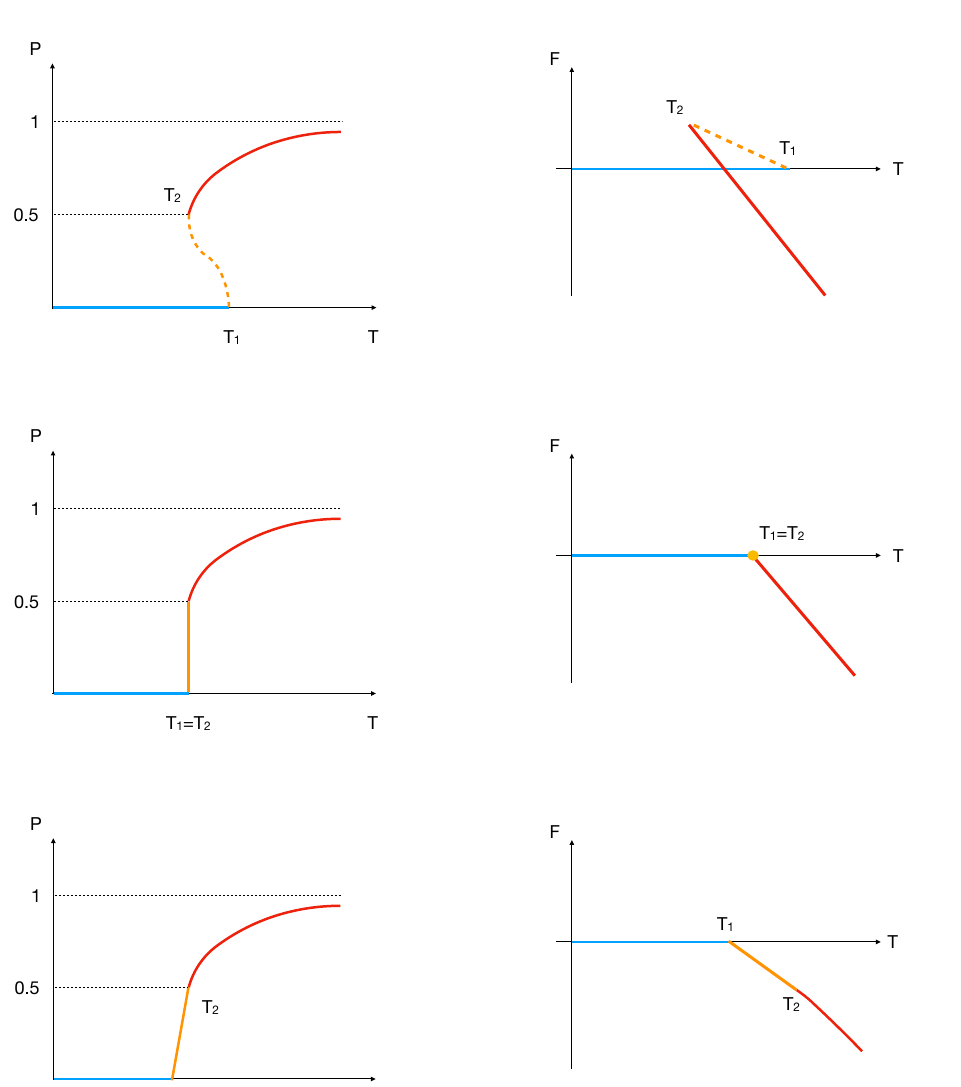
Figure 3. Left: cartoon pictures of the possible phase diagrams of the bosonic BFSS matrix model in the canonical ensemble. In order, the three rows correspond to three decon(cid:12)nement transitions: (cid:12)rst order with hysteresis ( T 1 > T 2 ), (cid:12)rst order without hysteresis ( T 1 = T 2 ), and two transitions of second and third orders ( T 1 < T 2 ). Dashed lines represent unstable phases, while solid lines represent stable or metastable phases. The blue, orange and red lines correspond to the con(cid:12)ned, partially decon(cid:12)ned and completely decon(cid:12)ned phases. Right: corresponding free energies for the three types of scenarios. See text for details. Here we use j P j = P .